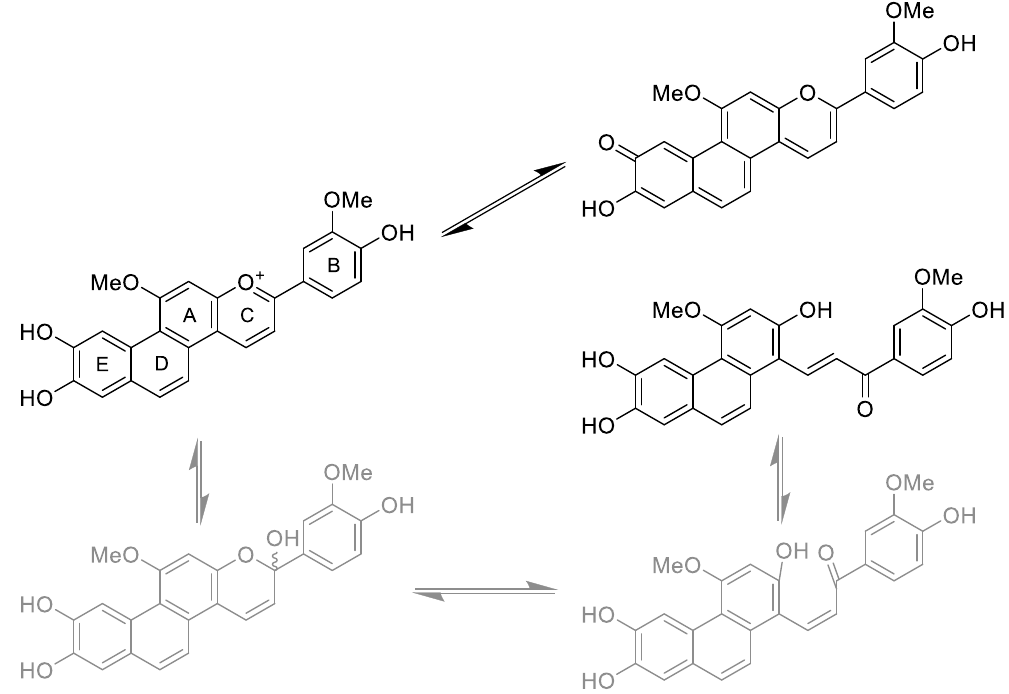
Scheme 1. The hemiketal and cis- chalcone forms were short-lived and not experimentally detected (represented in the figure with faded structures). The quinoidal base in the figure represents various structures differing in the position of the carbonyl function.